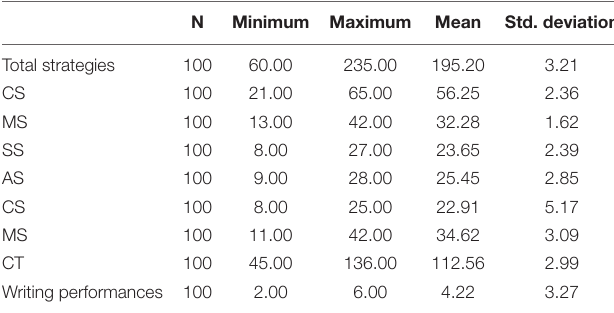
TABLE 3 | Descriptive statistics of the research